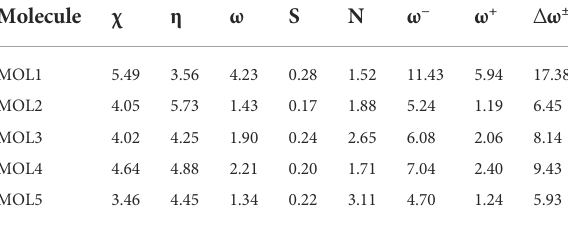
TABLE 6 Global reactivity descriptors for the studied molecules (all in eV), but Softness S, in eV − 1 . Molecule χ η ω